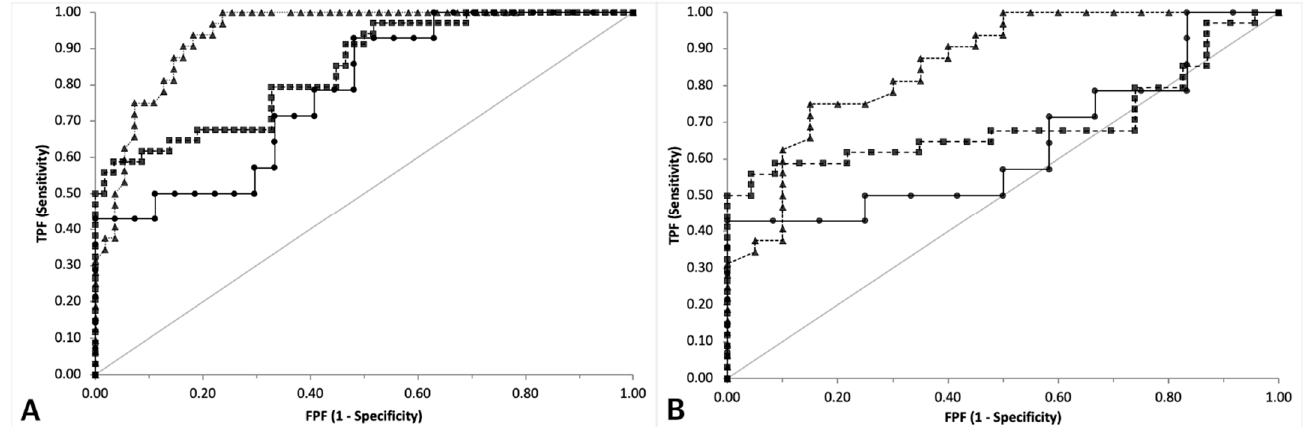
Figure 2. Correlations between CRP and PCO ( A ), PON1 and PCO ( B ), and CRP and PON1 ( C ). The ROC curve analysis (Figure 3) on the whole caseload demonstrated that all the three analytes had a discriminating power for sepsis ( p < 0.001 compared with the line of no discrimination) (Table 2). However, the area under the curve (AUC) of PON1 and of CRP were significantly higher than the AUC of PCO, but not significantly different to each other ( p = 0.990).